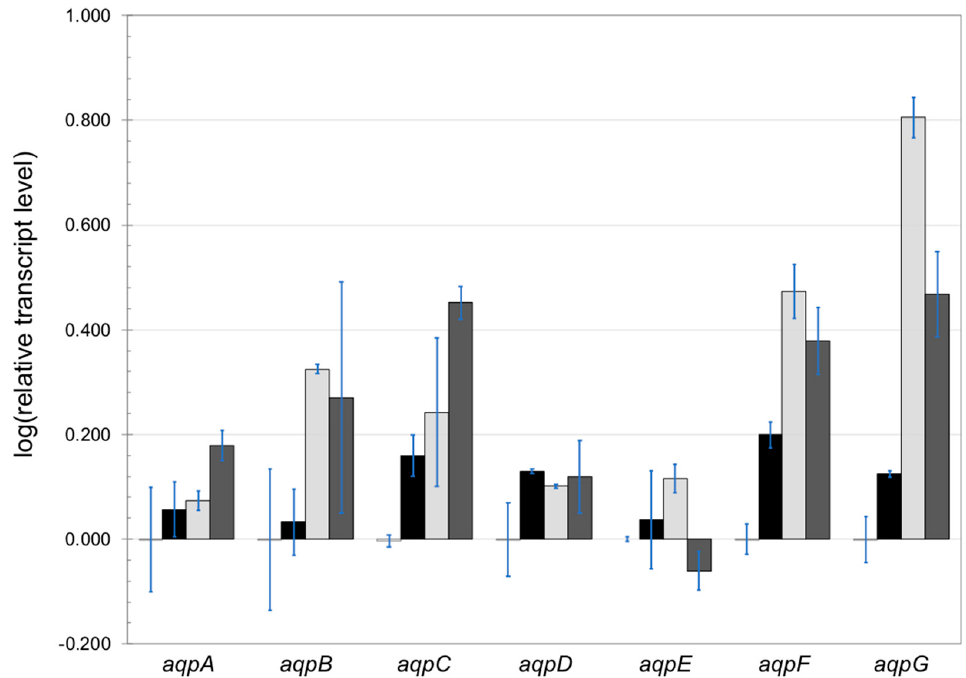
Figure 5. Expression of A. niger aqp genes under varying concentrations of hydrogen peroxide. Sam- ples were taken 3 h after mycelium transfer to a medium containing various concentrations of hy- drogen peroxide: from left to right: no hydrogen peroxide added, 2 mM (black), 10 mM (light gray), and 75 mM (dark gray) hydrogen peroxide. The expression analyses were performed by RT − qPCR. The transcript level of the histone − like gene was used to normalize transcript levels. Results are represented in relative transcript ratio in logarithmic scale (log10) with means of two biological rep- licates.